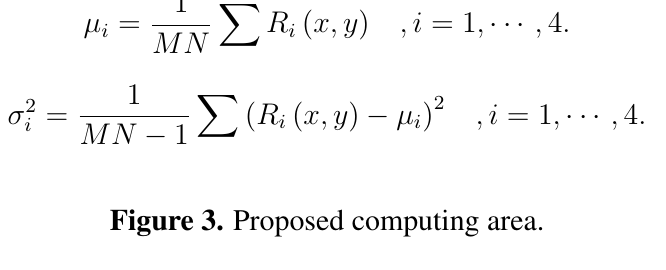
Figure 3. Proposed computing